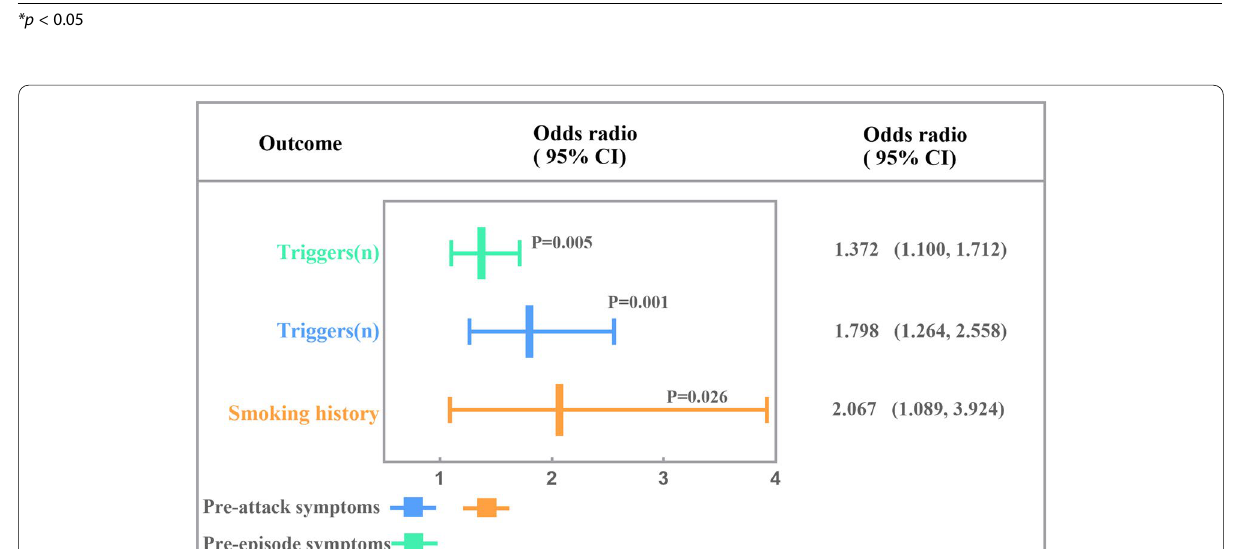
Fig. 4 Multivariable logistic regression analyses to assess factors associated with PAS and